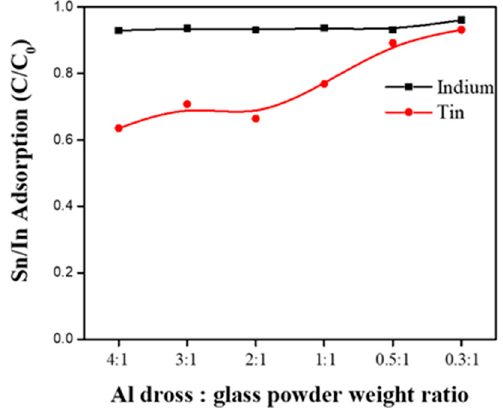
Figure 5. Adsorption of the behavior of the synthesized zeolite from the waste to waste stream combination.